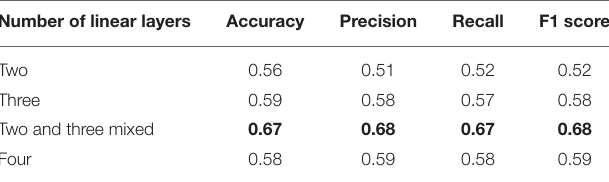
TABLE 7 | Different numbers of linear layers on multi-layer perceptron (MLP)